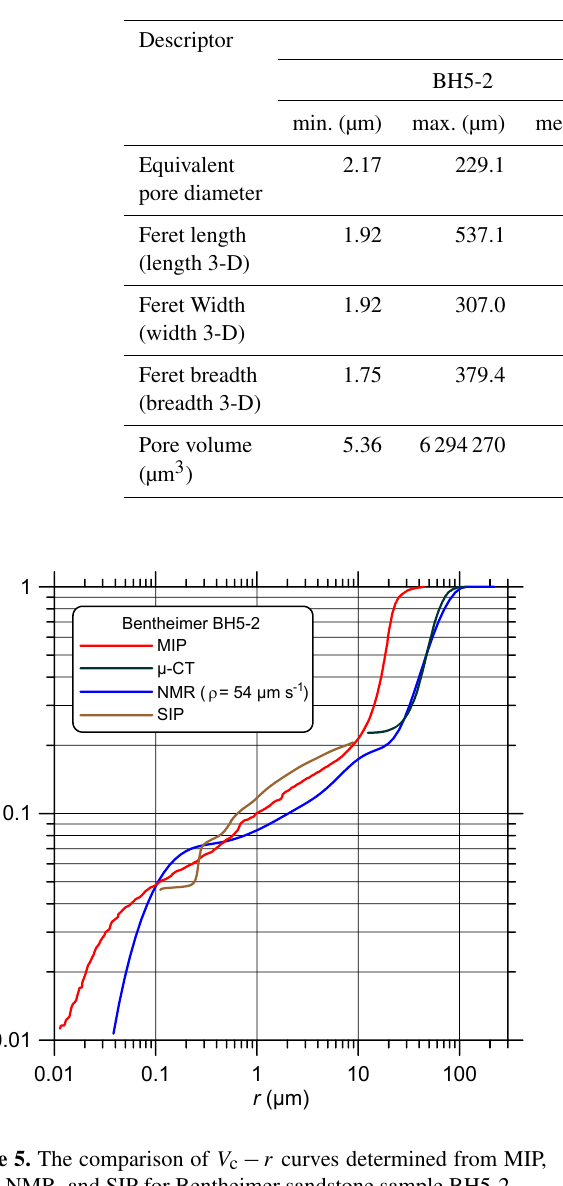
Table 3. Geometrical parameters of individual pores derived from µ -CT data of the two samples.